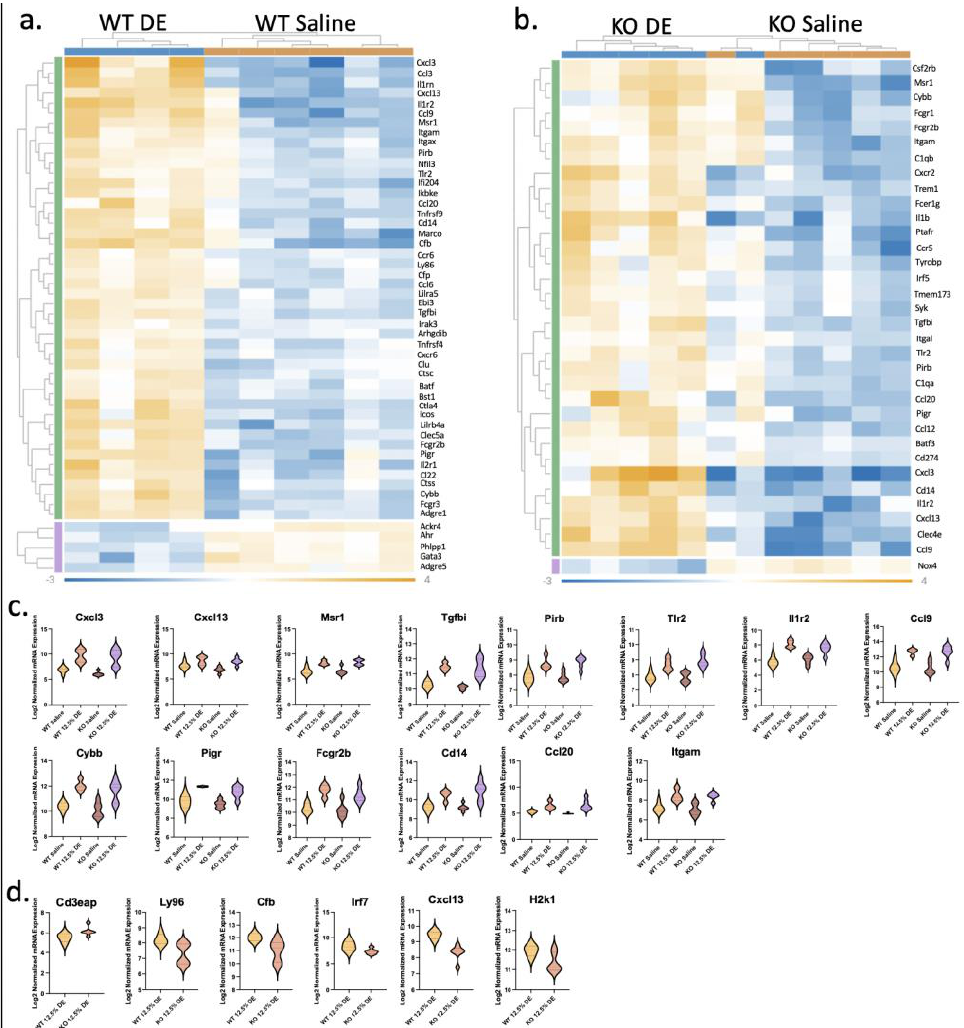
Figure 5. Dust-induced differentially expressed genes in total lung RNA from repetitively exposed mice. Total lung bulk RNA from mice repetitively exposed to 12.5% DE or saline was analyzed by the mouse immunology NanoString nCounter panel. Significant genes (Adj. p ≤ 0.05) with a fold-change of +/−1.5× are reported as heat maps of differentially expressed genes (DEG) in DE-exposed WT mice compared with WT saline controls (( a ), 51 genes) or DE-exposed KO mice compared with KO saline controls (( b ), 34 genes). One of the KO DE samples clusters with the saline group, which could be an artifact of poor intranasal delivery. Violin plots of the ( c ) 14 DEGs overlapping in both DE-exposed WT and KO samples compared with their genotype-matched saline controls (Adj. p < 0.05, FC: +/−1.5×) and ( d ) 5 DEGs between DE-exposed KO compared with WT ( p < 0.05, FC: +/−1.5×).